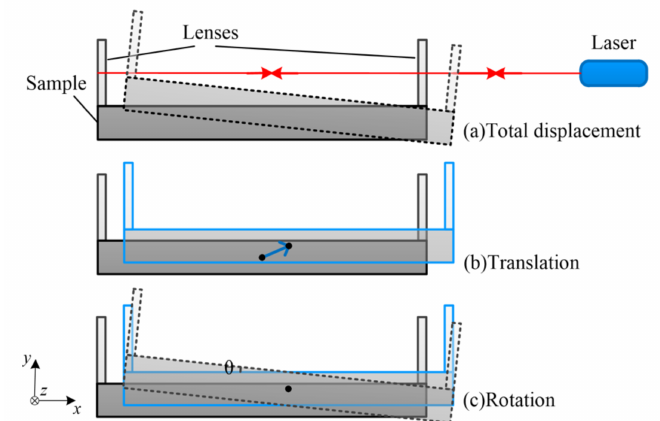
Figure 4. Schematic diagram of the micro-displacement decomposition. ( a ) Total displacement. ( b ) The translational component. ( c ) The rotational